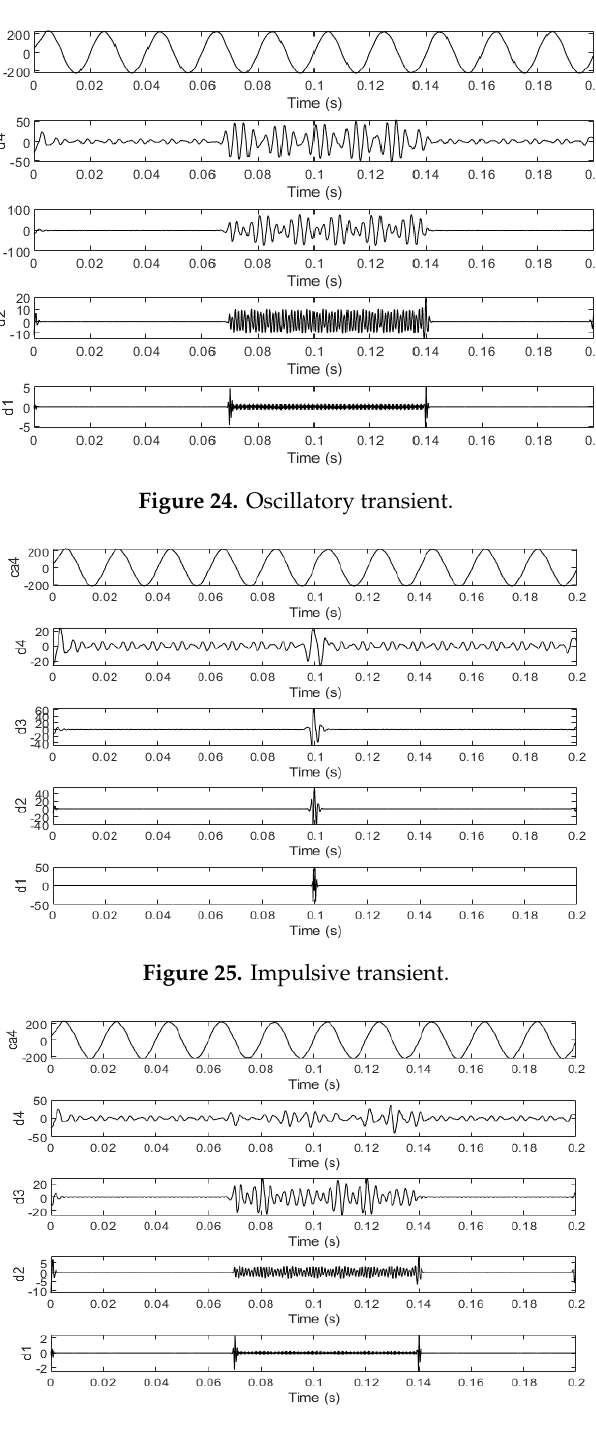
Table 2. The test results of the disturbances start time point.